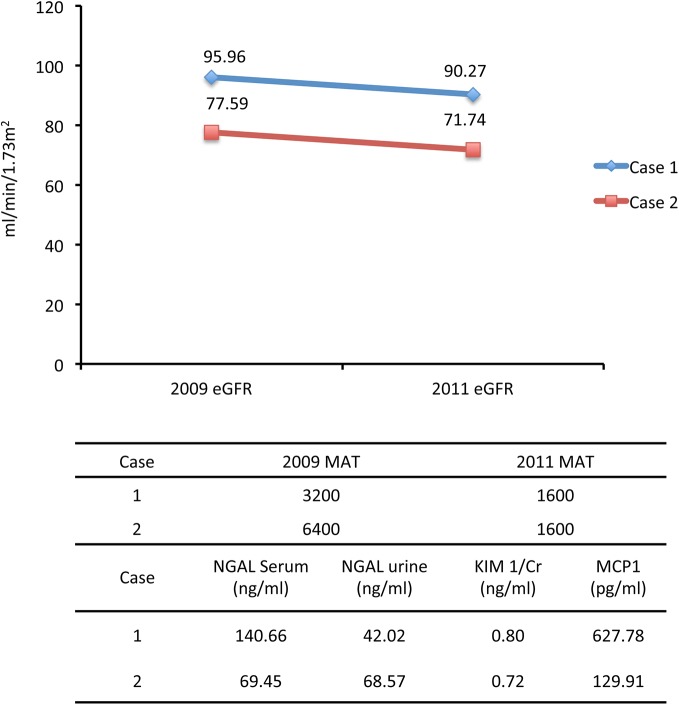
The eGFR, MAT titer and kidney injury marker changes in two cases with leptospira DNA positive urine.(Case I: dark blue; Case 2: light blue).